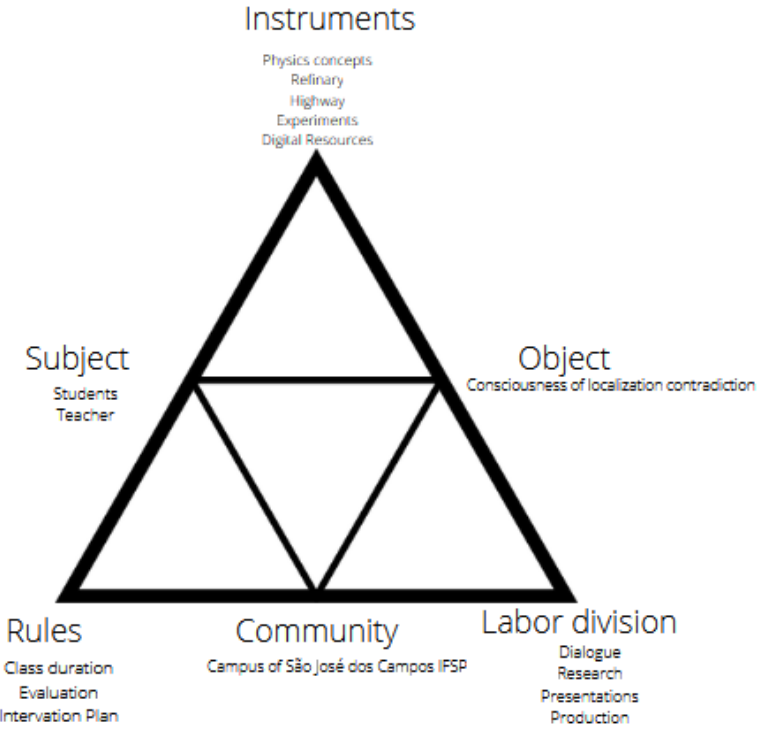
Figure 2: Dialogical Activity during a face-to-face situation (Santiago,